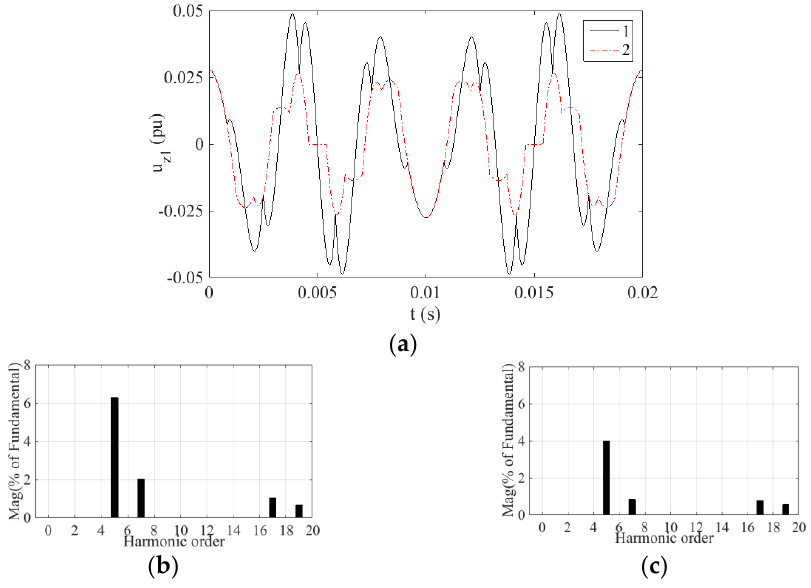
Figure 8. Simulation results u z1 of two strategies at m = 0.605. Here, 1 denotes the TFOS strategy, 2 denotes the proposed HSOS strategy: ( a ) u z1 waveforms of the two strategies; ( b ) Spectrum analysis of the TFOS; ( c ) Spectrum analysis of the proposed HSOS.